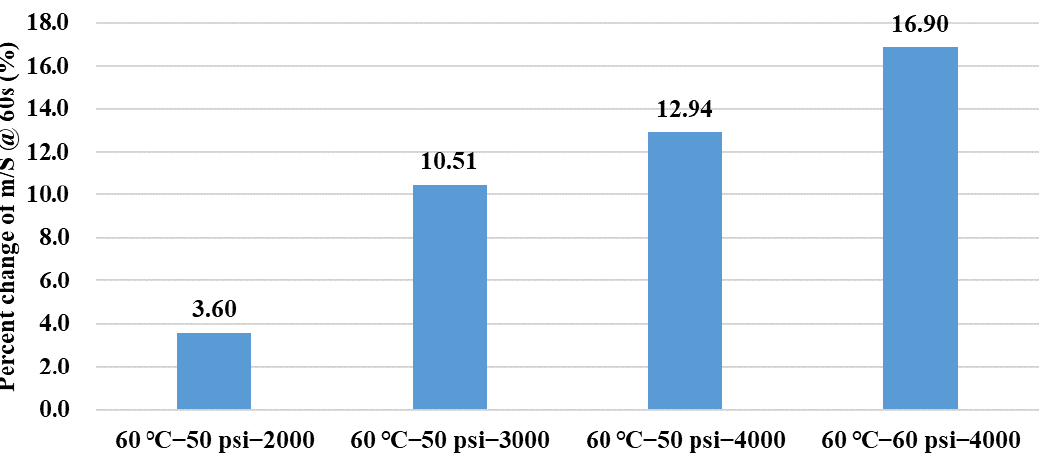
Figure 12. Percent change of m/S at 60th s in BBR tests.